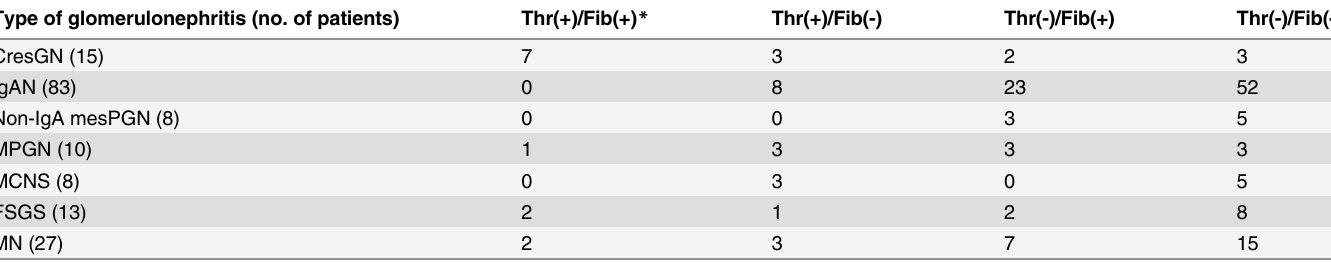
* Thr and Fib indicate thrombinuria and fi brin deposition, respectively. Fibrin deposition was determined via immuno fl uorescence microscopy, and thrombin activities > and below the detection limit (0.2 U/L) were regarded as positive (+) and negative (-) thrombinuria, respectively. CresGN indicates crescentic glomerulonephritis; IgAN, IgA nephropathy; Non-IgA mesPGN, non-IgA mesangial proliferative glomerulonephritis; MPGN, membranoproliferative glomerulonephritis; MCNS, minimal change glomerulopathy; FSGS, focal segmental glomerulosclerosis; and MN, membranous